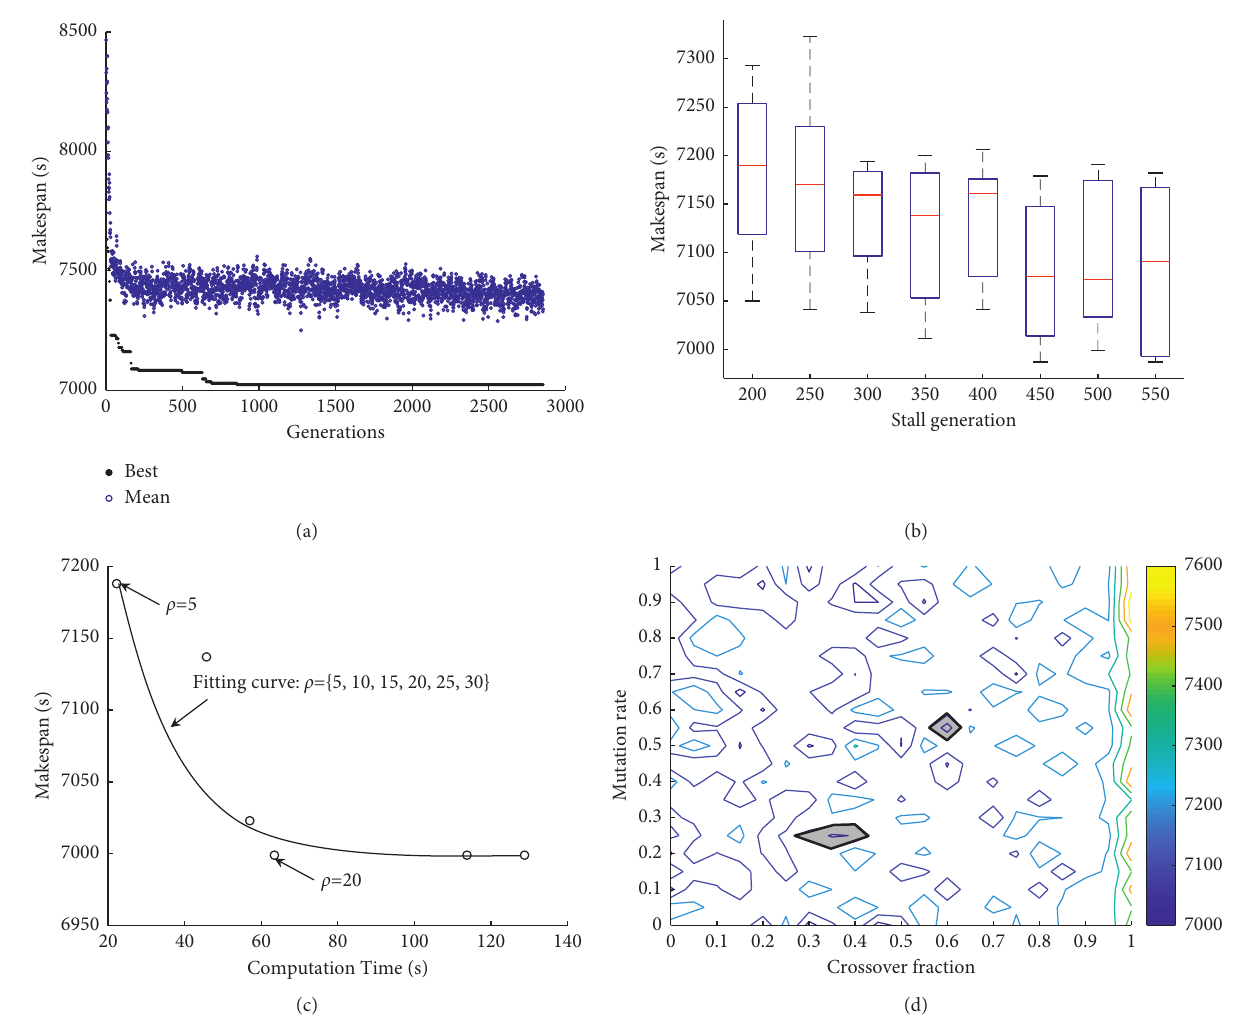
Fitting curve: ρ ={5, 10, 15, 20, 25, 30}